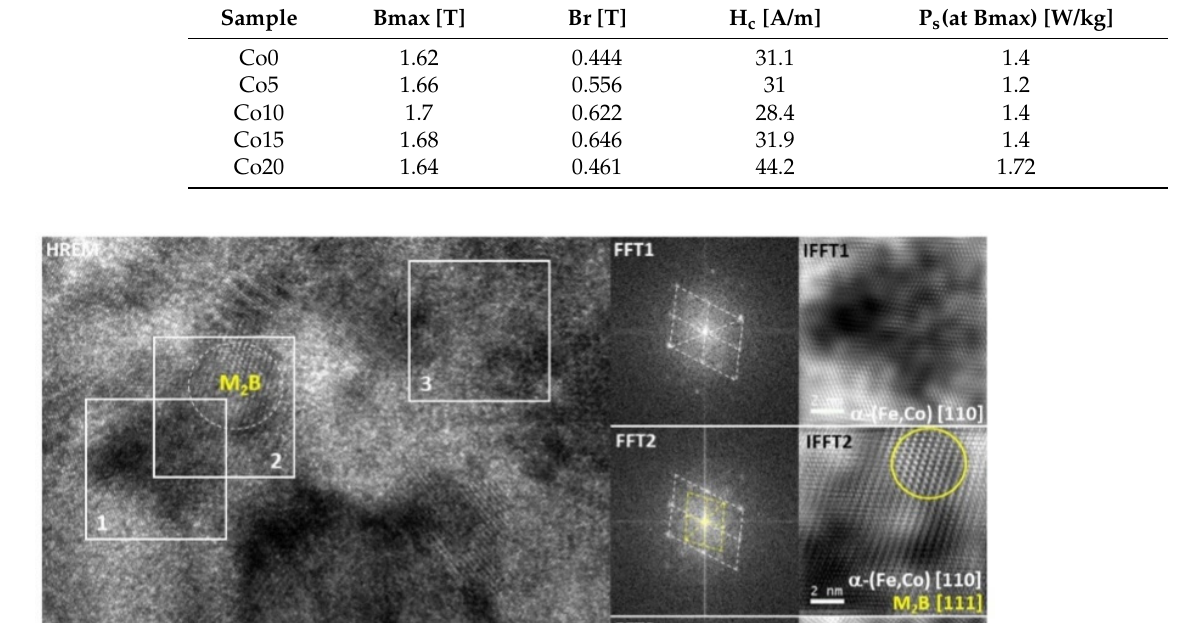
Figure 9. HREM image with corresponding FFT and IFFT taken from marked areas of the Fe 69.5 Co 5 Nb 5 B 8.5 P 2 ribbon.